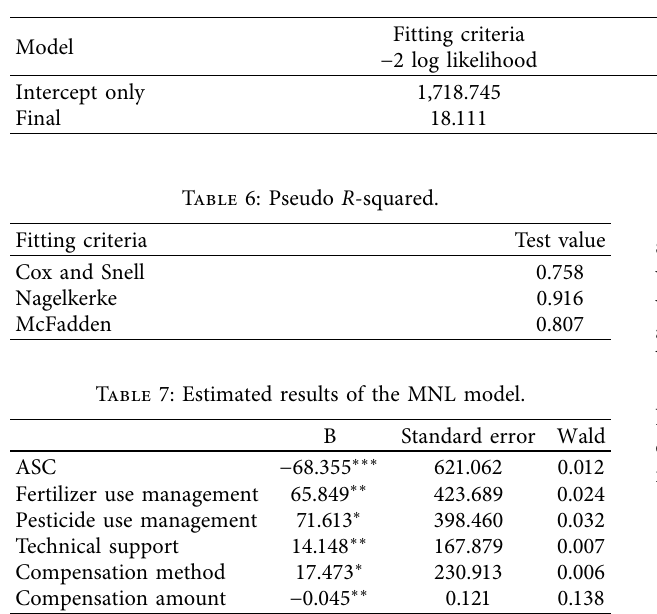
Table 5: Model fitting information.